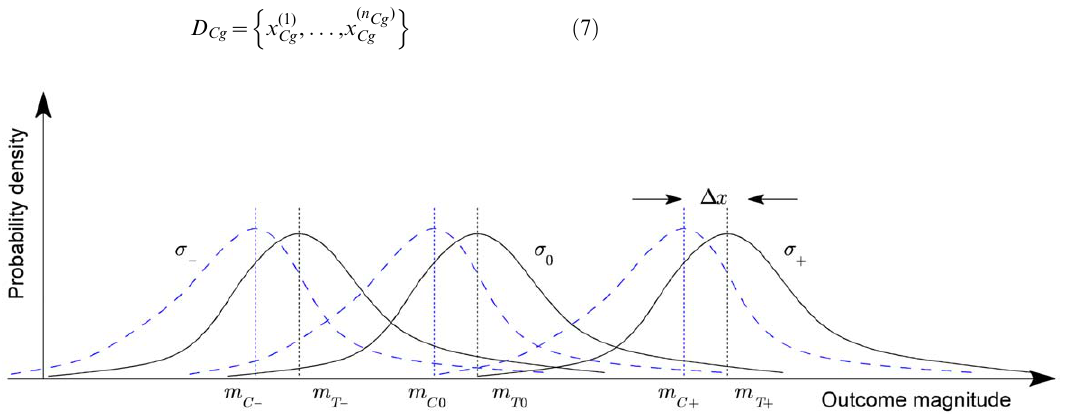
Figure 3. A conceptual illustration of the proposed statistical model for the 3-tier participants’ feedback questionnaire: (i) belief in treatment assignment, (ii) belief in control assignment and (iii) uncertain (‘‘don’t know’’). Dotted and solid lines show respectively the probability density functions of the measured trial outcome across individuals in the three control and treatment sub-groups. Parameters s g and m ag denote the corresponding standard deviation and the mean of each sub-group, and D x the differential effect of treatment.